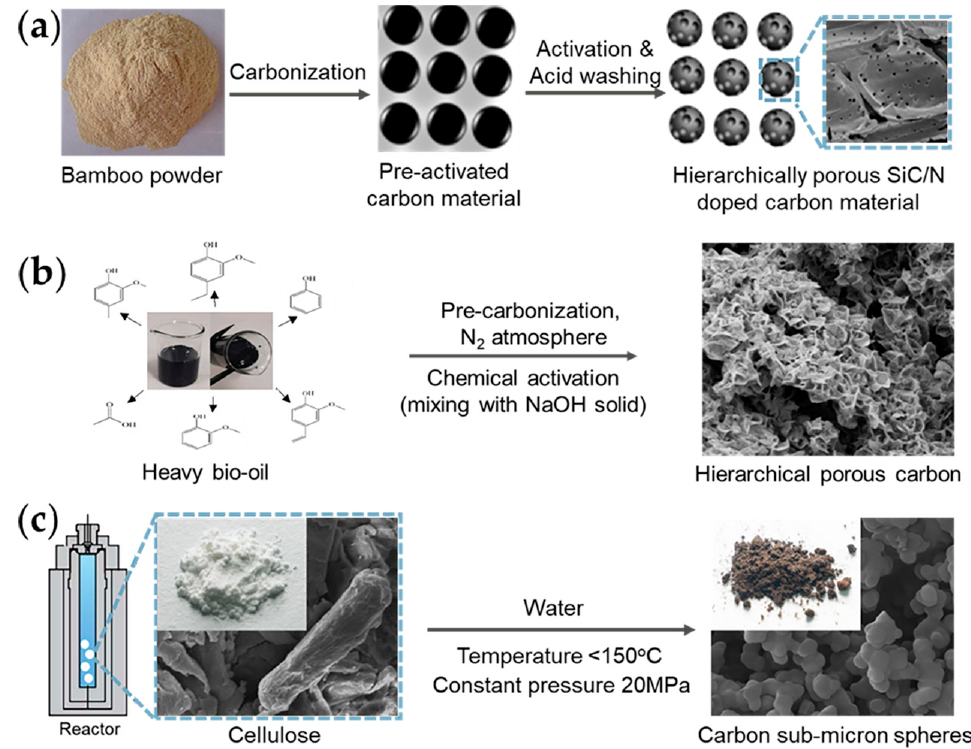
Figure 7. ( a ) A carbon material with a dual-doped SiC/pyrrolic-N pore structure is generated from the pyrolysis and activation of bamboo powder [62]. ( b ) After heat and activation treatment, the rice husk pyrolysis by-product is converted into a three-dimensional bonded porous structure with surface oxygen-containing functional groups [64]. ( c ) Synthesis of submicron carbon spheres from cellulose by the hydrothermal system (independently controlling temperature and pressure) [70].